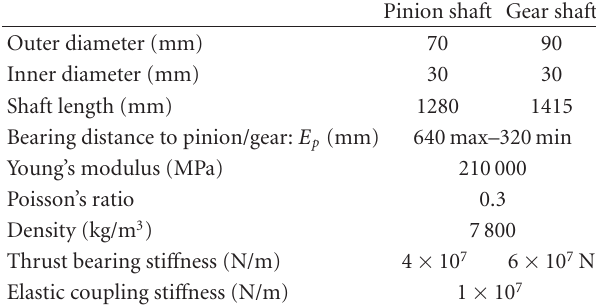
Table 2: Shaft data.